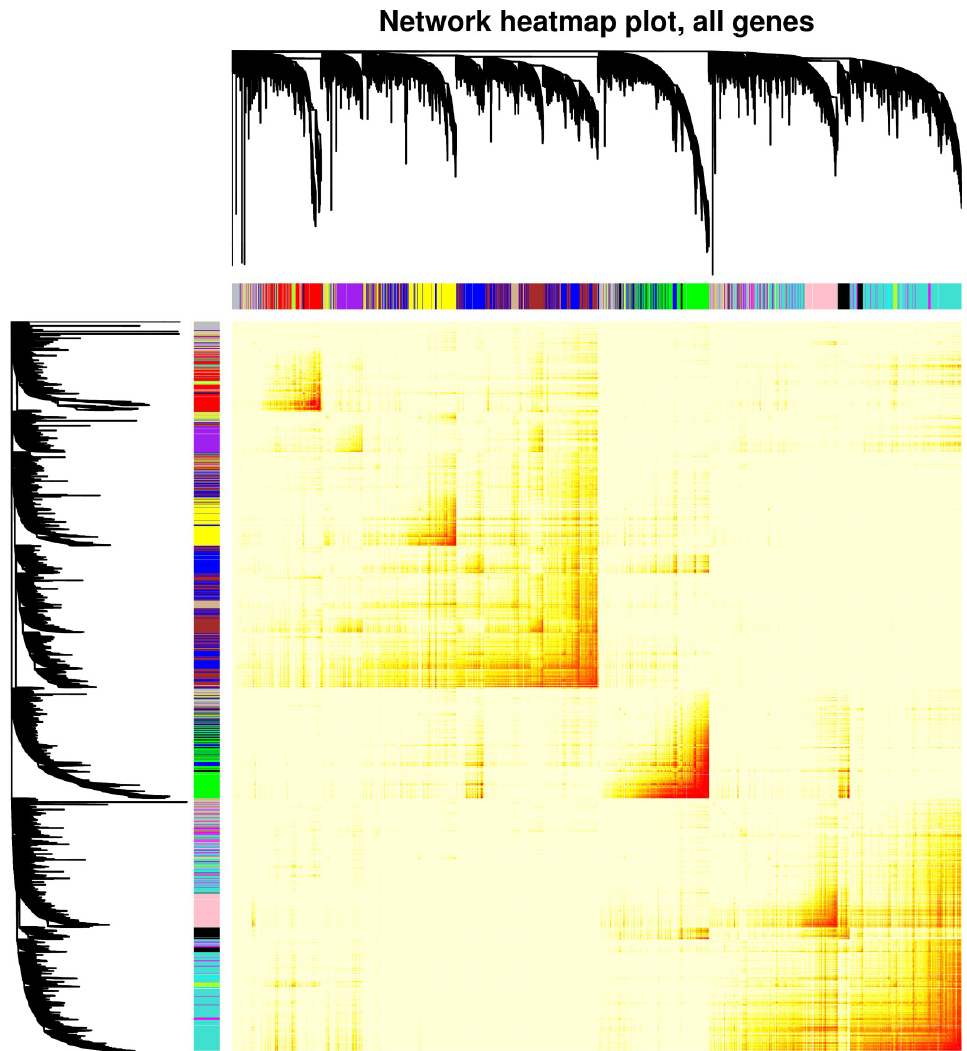
Fig 1. Visualization of the gene co-expression network modules and module relationships. The co-expression network was built by considering all TNFa stimulated and unstimulated samples together. Hierarchical clustering dendogram of 14,019 genes expressed in HUVEC cell lines, along with colors representing module assignments. Genes that are not assigned to any module are colored grey. The heatmap shows the topological overlap matrix, and darker coloring indicates higher topological